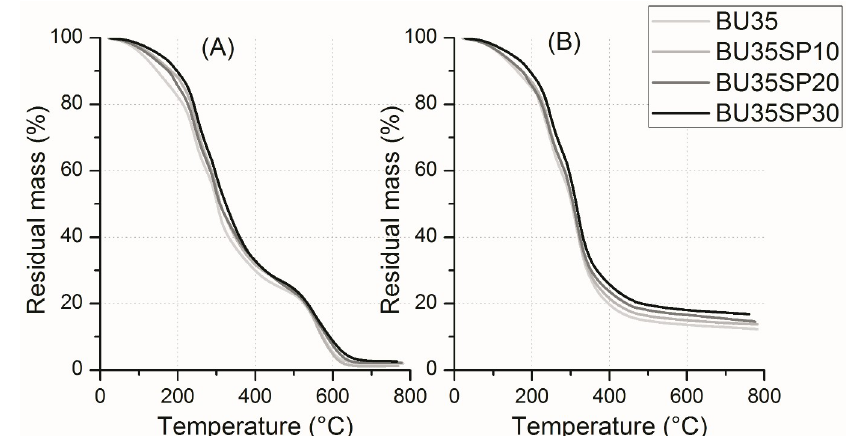
Figure 3. Thermogravimetric analysis (TGA) curves between T amb and 800 °C of samples plasticized with 1,4-butanediol with 0, 10, 20, and 30 php of microalgal biomass, in air ( A ) and nitrogen ( B ).